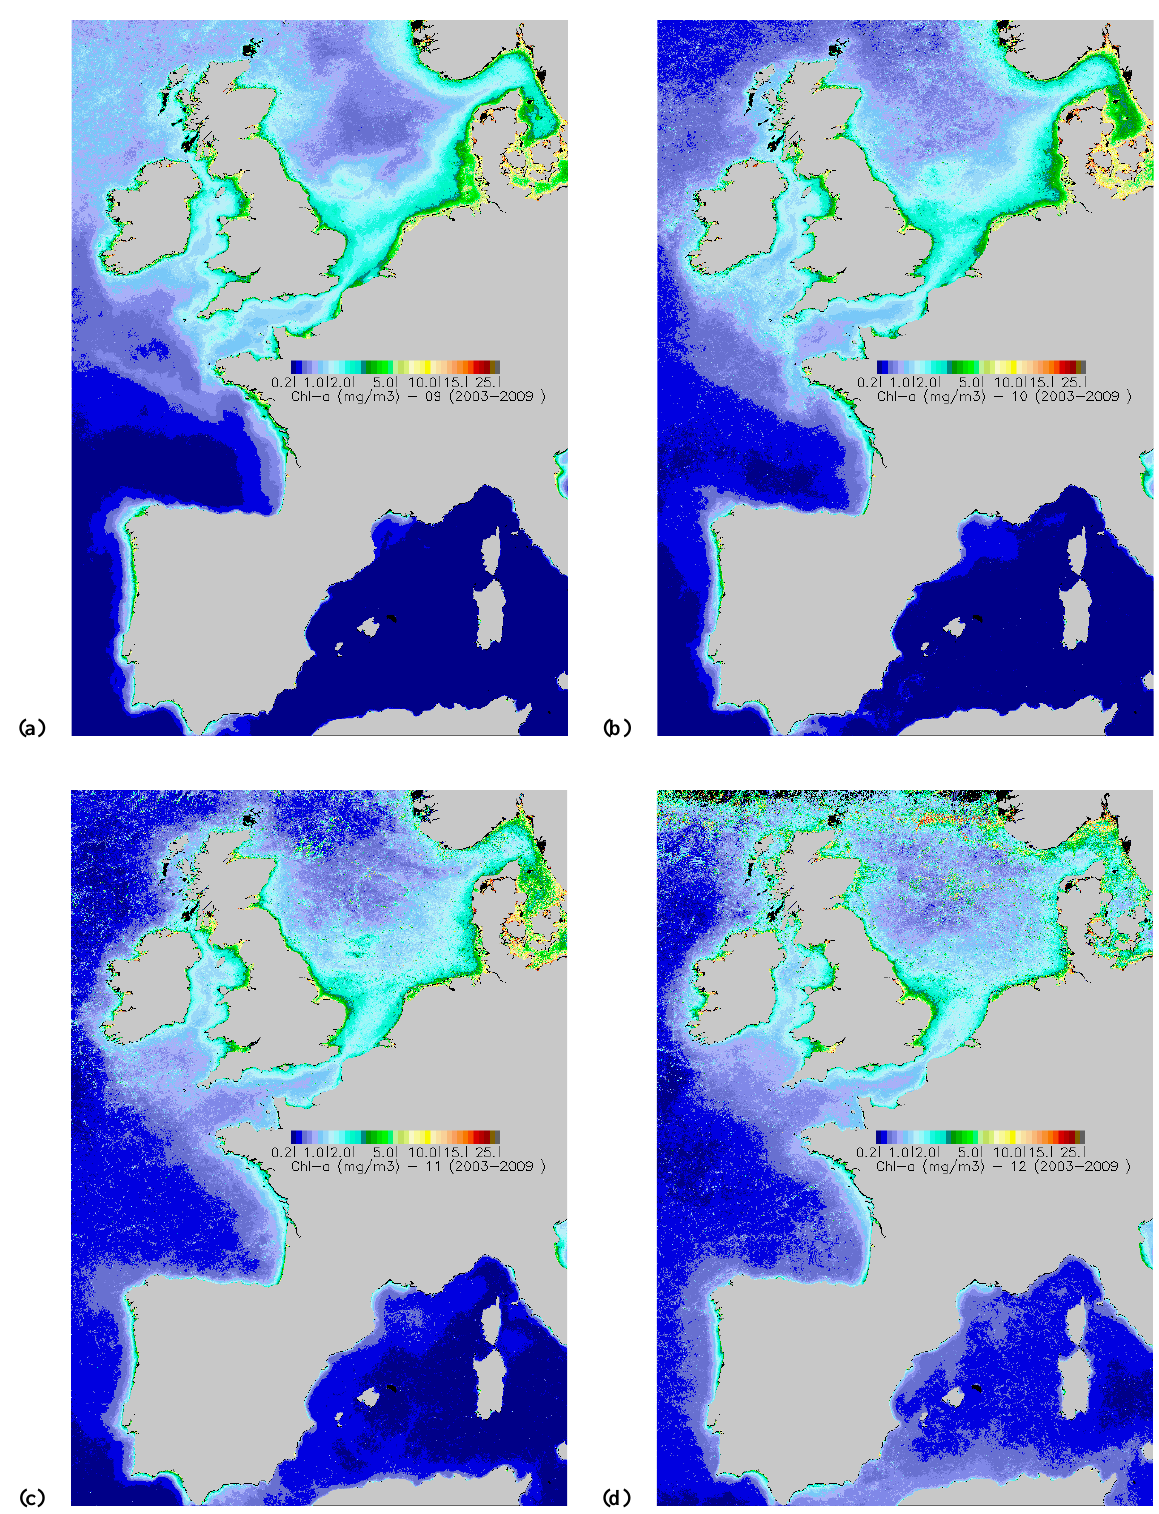
Fig. A3. Monthly chlorophyll- a concentration in September (a) , October (b) , November (c) and December (d) .